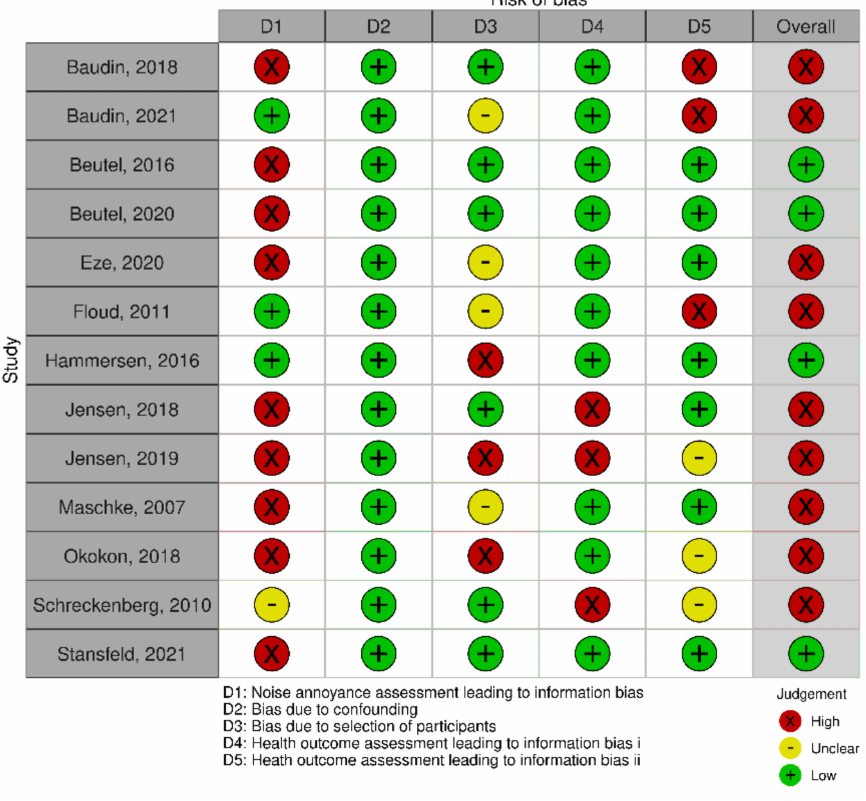
Figure A2. Risk of bias